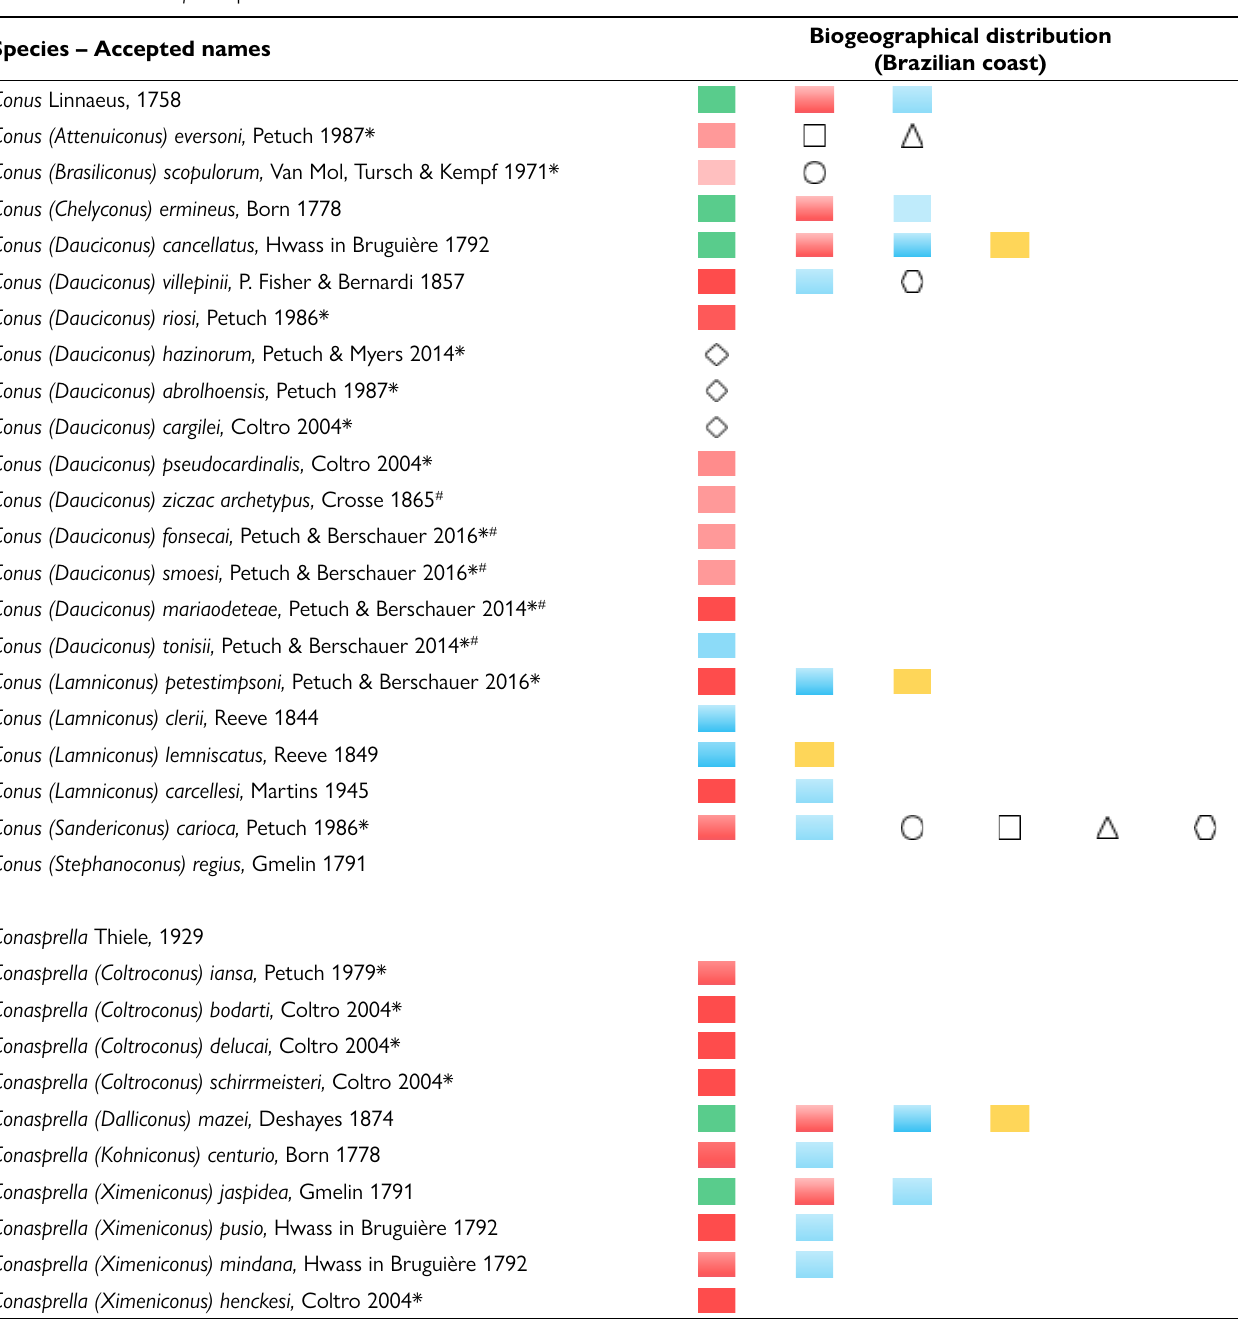
Table 3. Conus and Conasprella species found off the Brazilian